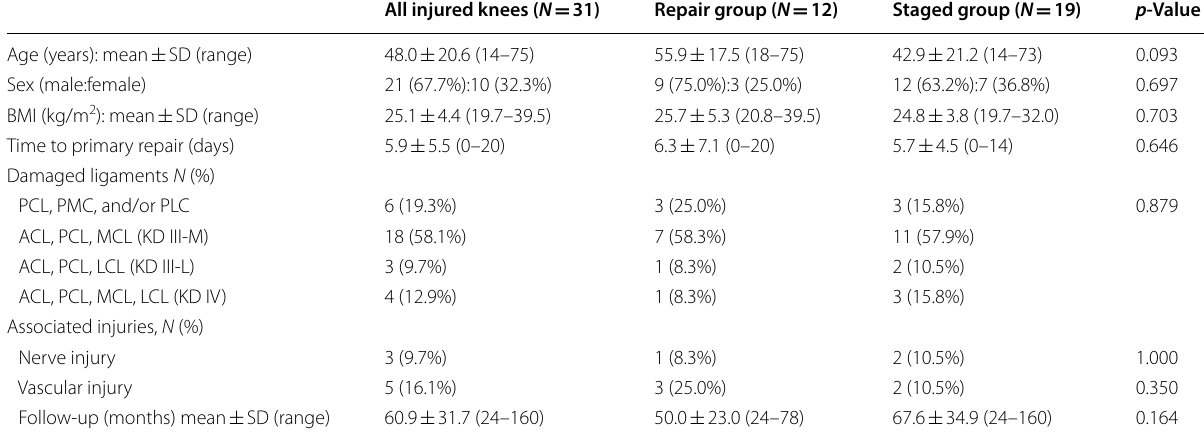
SD standard deviation, N number, BMI body mass index, ACL anterior cruciate ligament, PCL posterior cruciate ligament, PMC posteromedial corner, PLC posterolateral corner, MCL medial collateral ligament, LCL lateral collateral ligament, KD knee dislocation